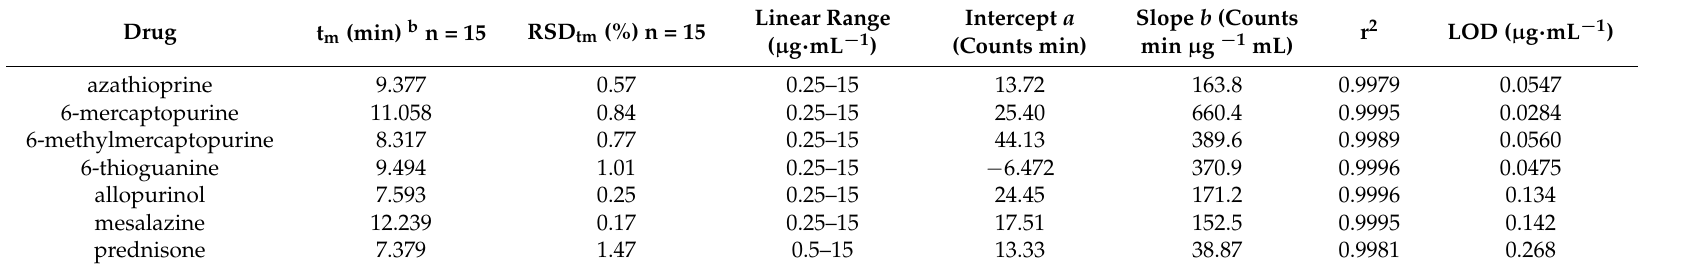
Table 2. Performance parameters of the CE-ESI-MS/MS method a .